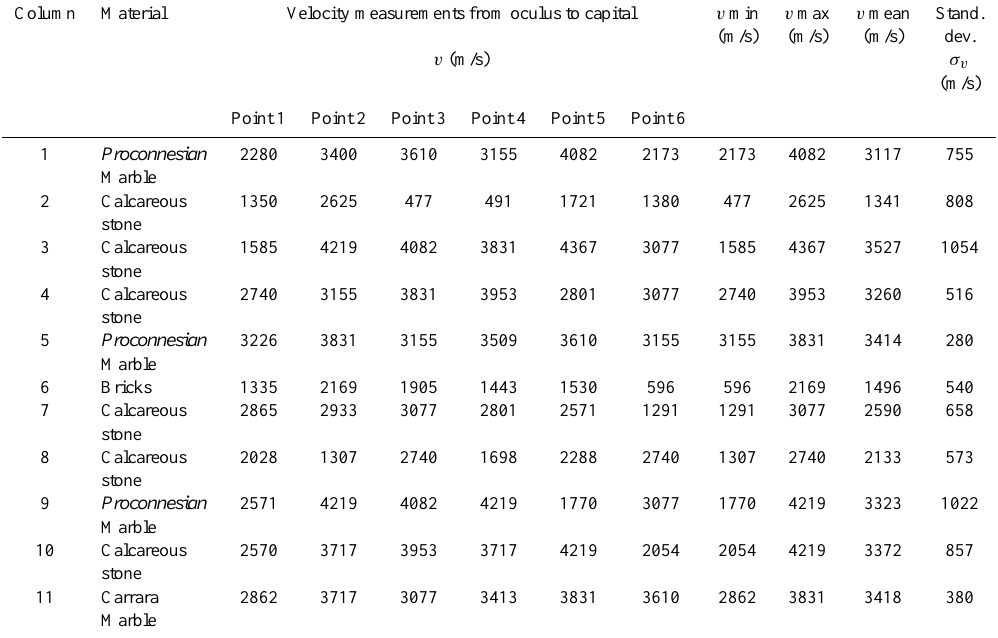
Table 2. Ultrasonic tests on the internal columns of the rose window.